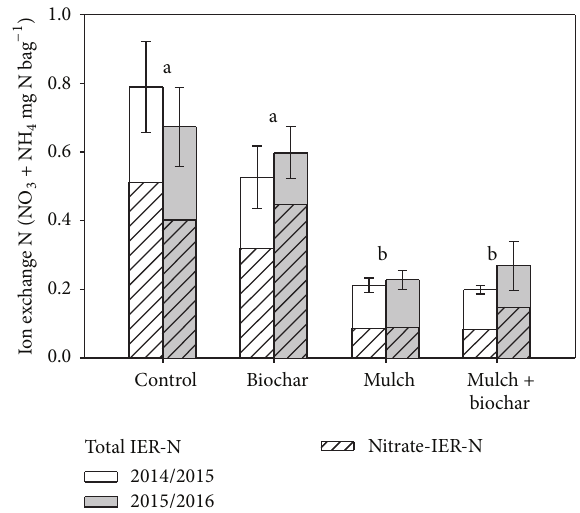
Figure 1: Ion exchange resin soil nitrogen comparing post-wildfire rehabilitation treatments at the Church’s Park burn,